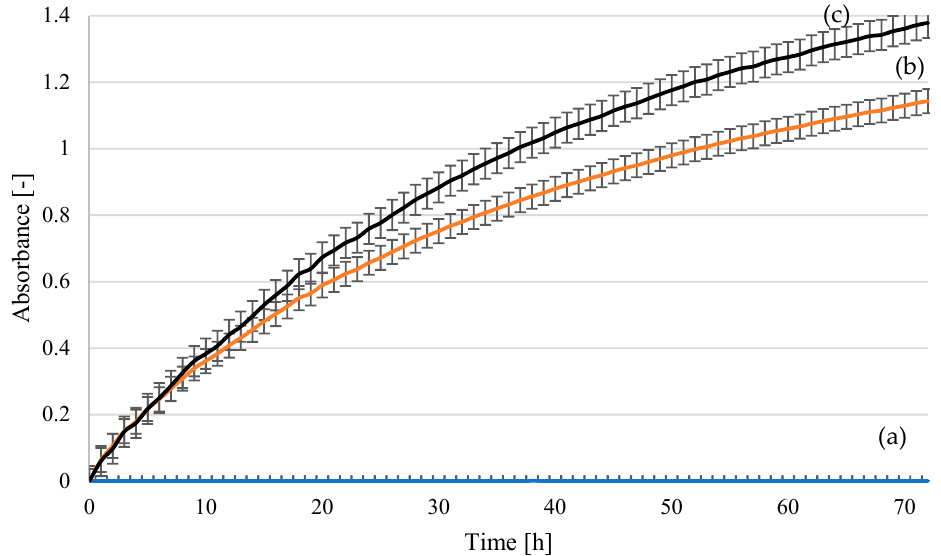
Figure 16. Yeast growth curves for Saccharomyces cerevisiae Ethanol Red strain in fermentation media: ( a ) uninoculated medium–reference sample; ( b ) hydrolysate following treatment at 140 ◦ C, 2 h, 2% H 2 SO 4 ; ( c ) hydrolysate following treatment at 140 ◦ C, 2 h, 2% H 3 PO 4 . The curves show the mean values obtained in three independent